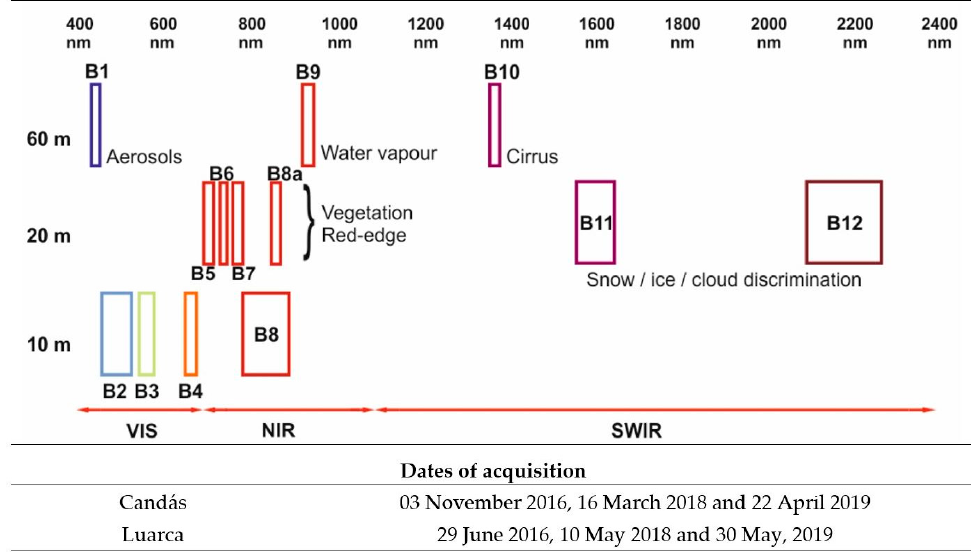
Figure 2. Sentinel-2 spectral bands vs. spatial resolution, and dates of acquisition.